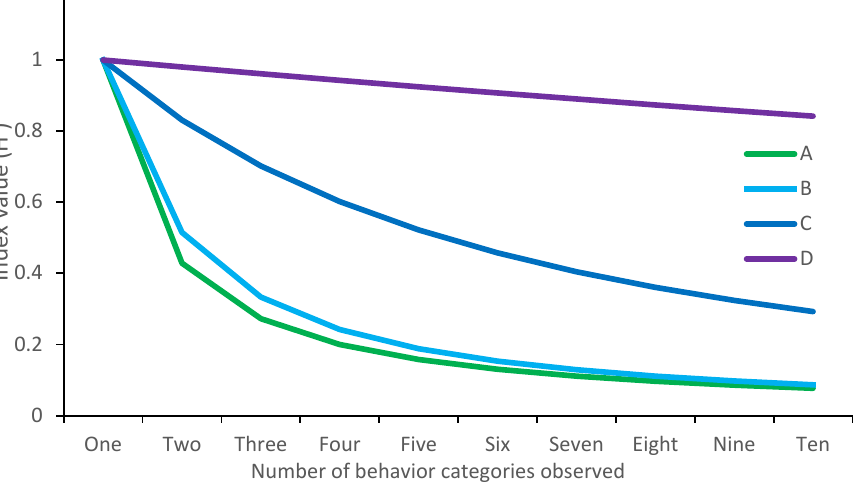
Figure 3. The effect of number of behaviors seen on Simpson’s index outputs, using simulated data. Simulation A demonstrates H’ outputs when all behaviors are seen an equal number of times. Sim- ulation B, C and D demonstrate H’ outputs when all behaviors occur equally frequently, apart from the first behavior which occurs 2 x, 10 x or 100 x, respectively, more frequently than the others.